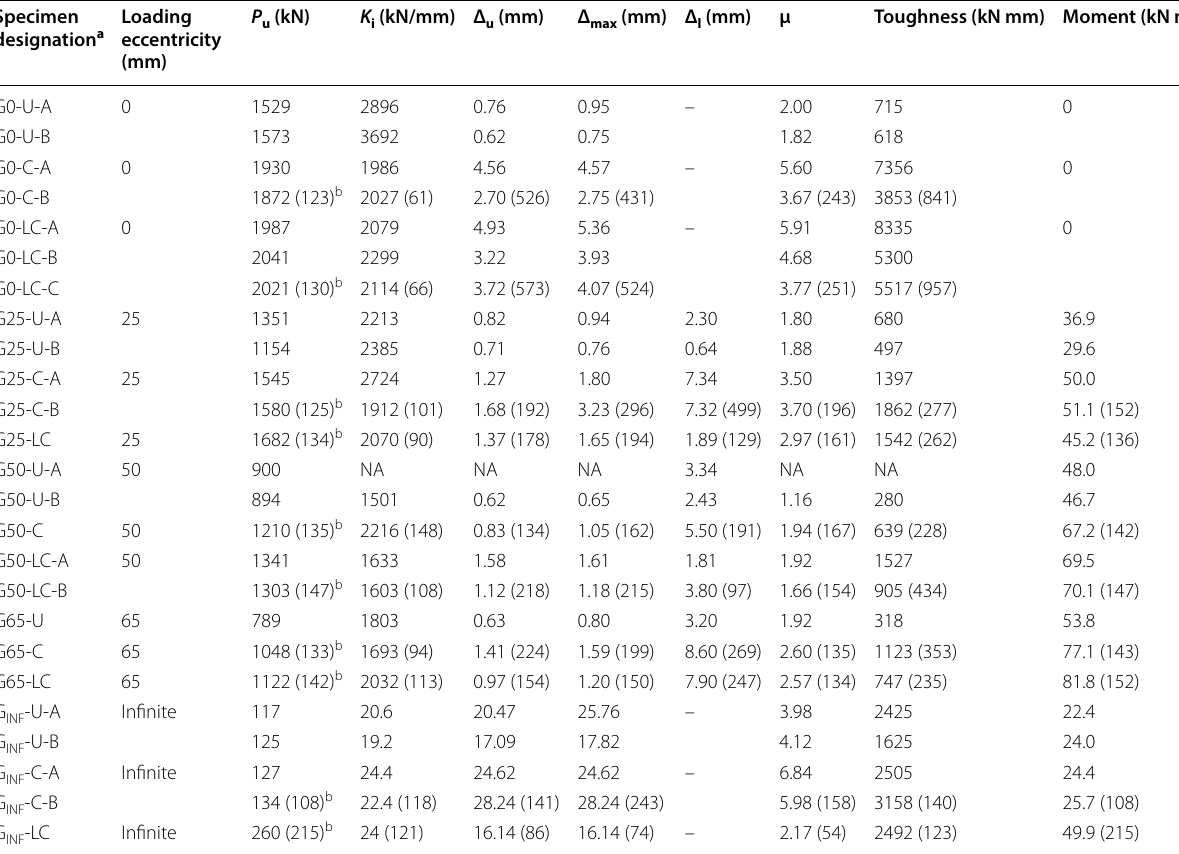
Table 1 Summary of test